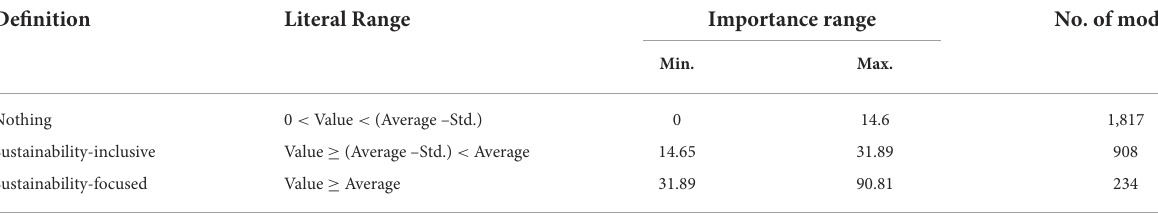
TABLE 4 Statistical definition of “sustainability-inclusive” and “sustainability-focused” modules based on SI values.